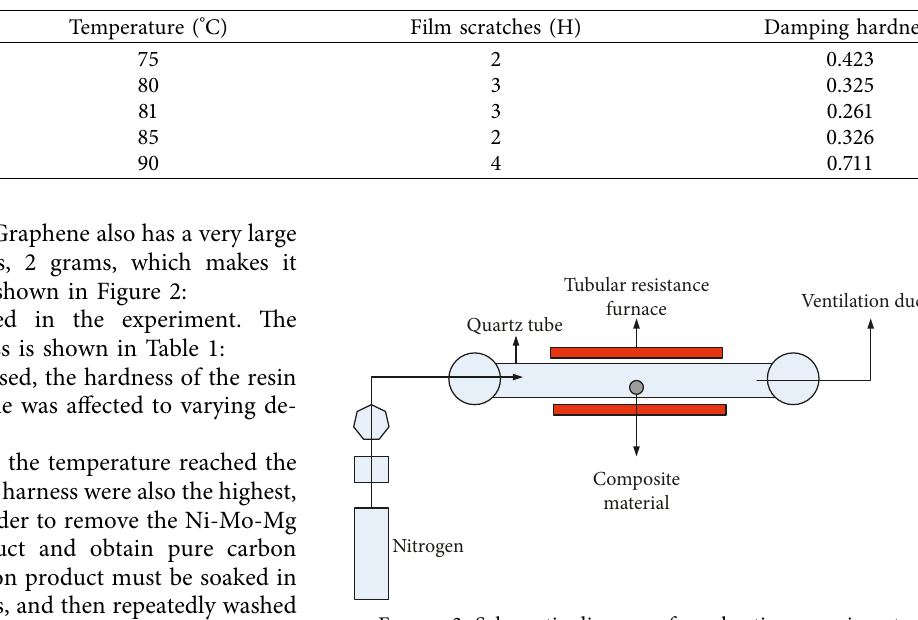
Table 2: Effects of different temperatures on resin hardness.